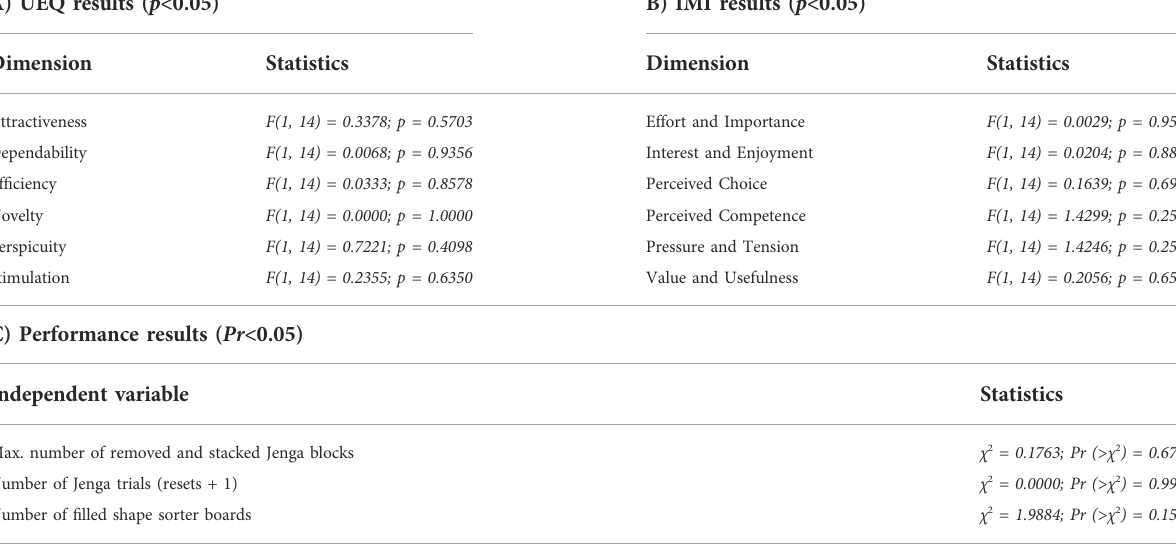
TABLE 1 Performance experiment results: (A) results of User Experience Questionnaire; (B) Intrinsic Motivation Inventory results; and (C) results of performance dimensions evaluation A) UEQ results ( p